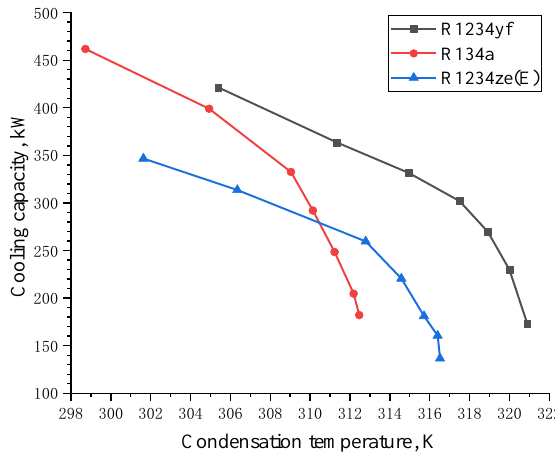
Figure 7. Cooling capacity at different condensation temperatures.